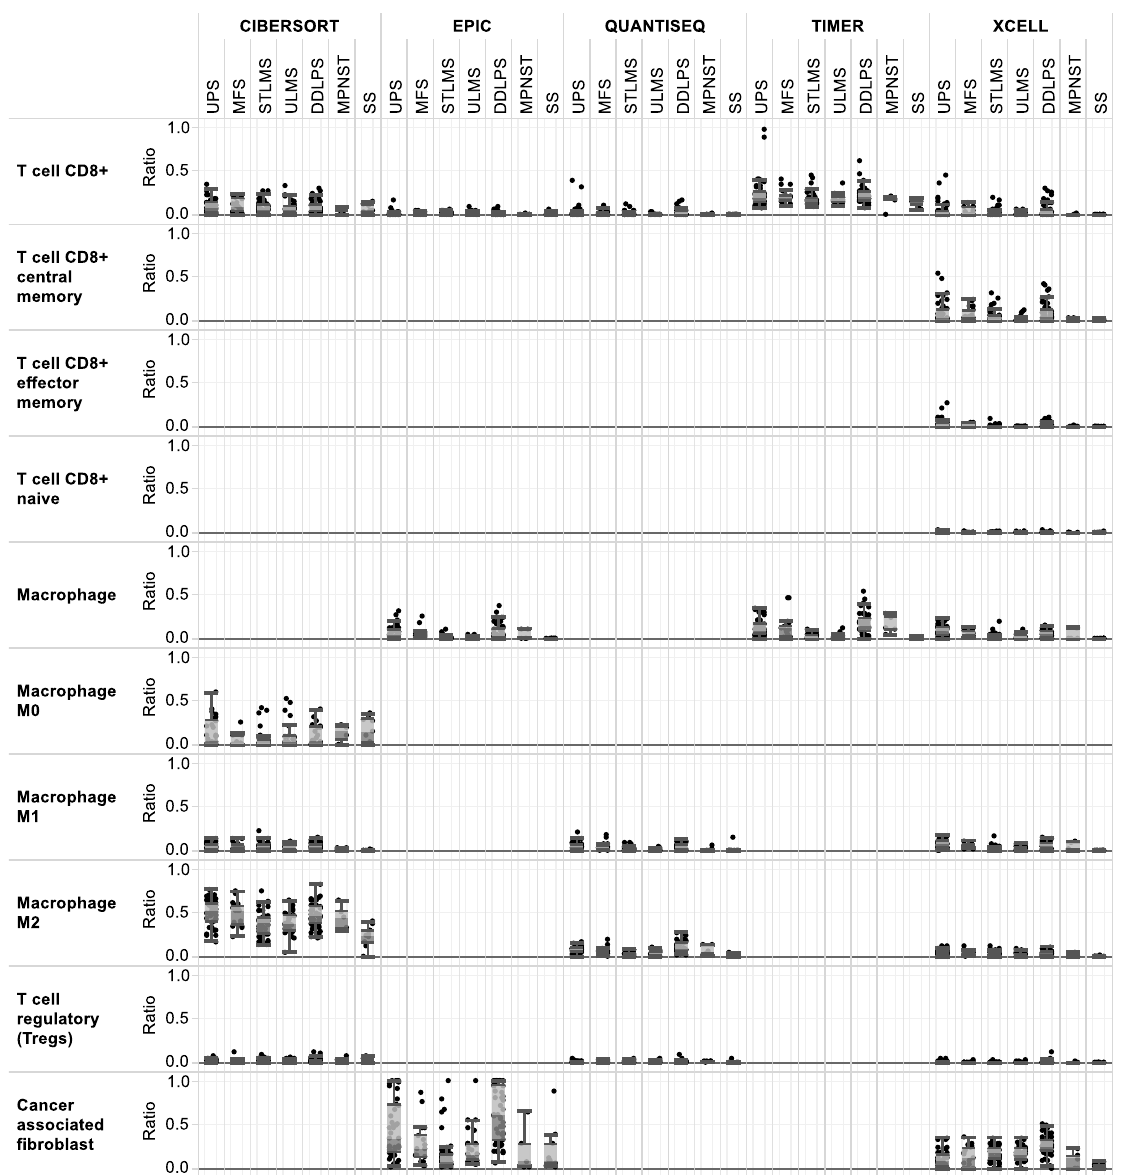
Figure 3. Immune infiltrate analyses using TCGA reveals CD8+ T cell, macrophage, T regulatory cell, and cancer-associated fibroblast levels in all soft tissue sarcoma subtypes. The y -axis represents the estimation of the immune infiltration level for a given cell type within the tumor infiltrate.